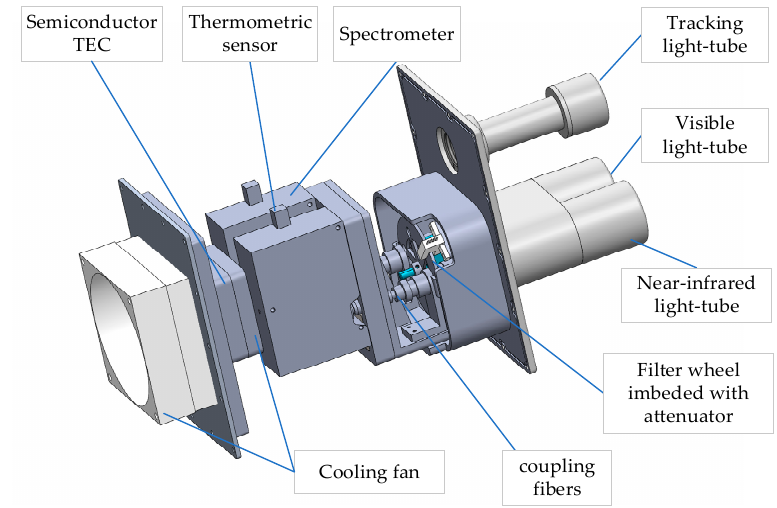
Figure 6. Three-dimensional structure of spectrum probe.